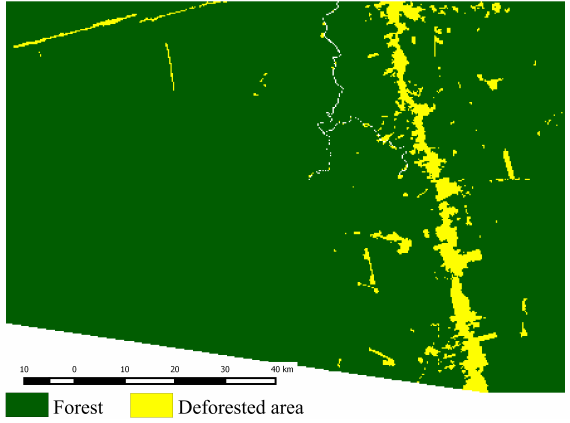
Figure 1: Land use / cover map (1997)